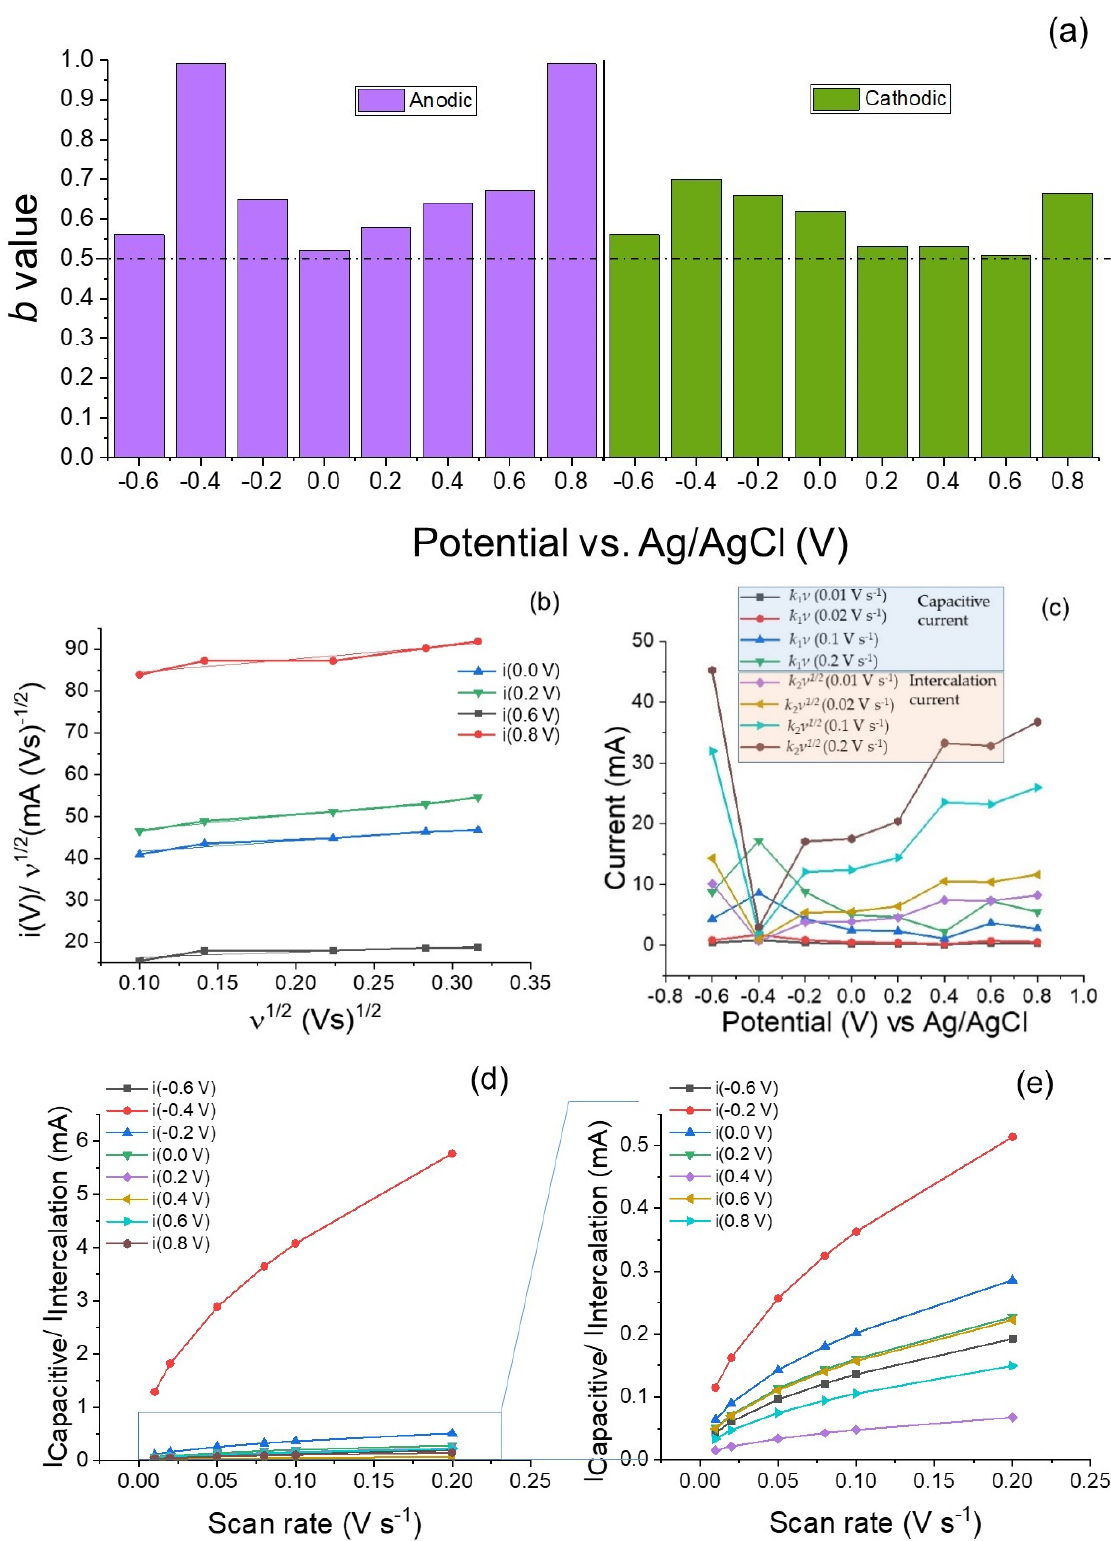
Figure 12. ( a ) b value determination from the peak anodic and cathodic currents (log i p vs. log scan rate); ( b ) linear fit of plots between υ 1/2 (square root of scan rate) and i ( V ) υ 1/2 ; ( c ) variation of capacitive and intercalation currents as a function of potential; ( d , e ) variation of capacitive and intercalation currents with scan rate.